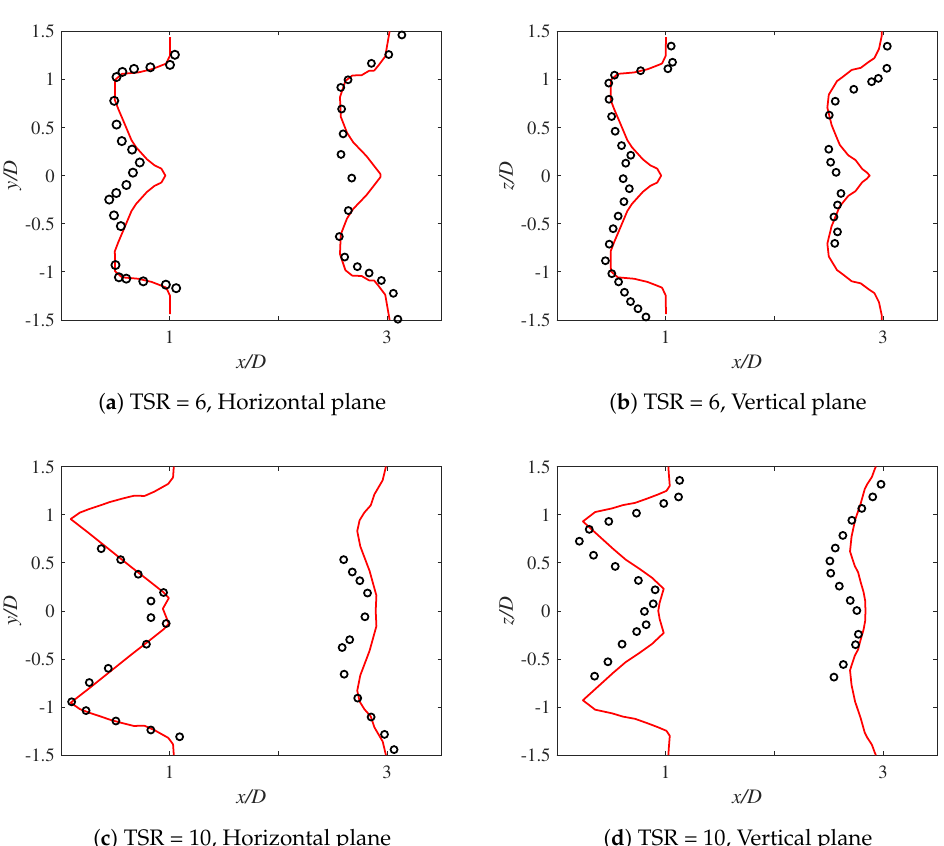
Figure 10. HAWT-S826: Comparison of the velocity deficit using Case-III (a 120 ◦ blade with axial symmetry), at successive locations of x / D of 1 and x / D of 3 in the wake region and TSR values of 6 ( a , b ) and 10 ( c , d ). Velocity profiles were predicted by MRF (solid lines) with the results of the experiment (circles) taken from [37]. Successive profiles were offset for better